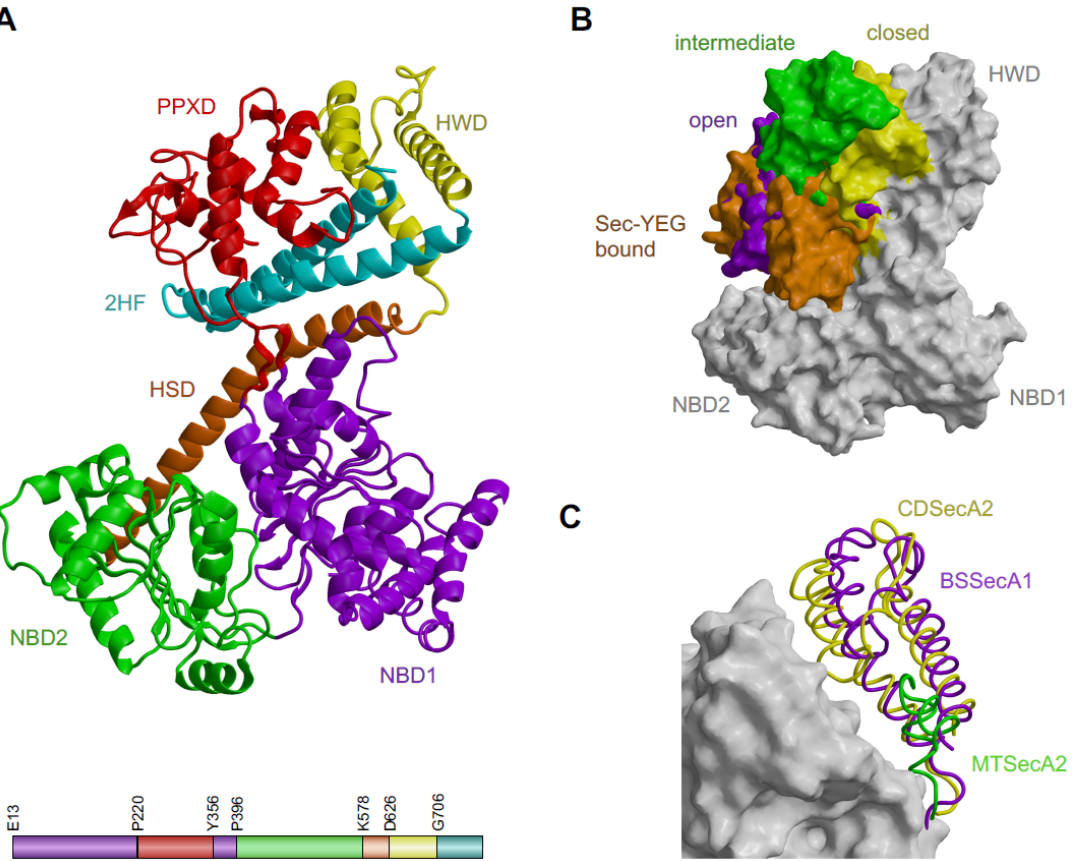
Figure 1. The crystal structure of apo CDSecA2 and conformational variability of SecA homologues. ( A ) The CDSecA2 crystal structure in closed conformation. Domains are color coded: violet, nucleotide-binding domain 1 (NBD1); green, nucleotide-binding domain 2 (NBD2); red, peptide cross linking domain (PPXD); orange, helical scaffold domain (HSD); cyan, two-helix finger (2HF) and yellow, helical wing domain (HWD). Locations of the domains in the linear sequence (bottom) define the color coding. The residues at the beginning of the domains are depicted. ( B , C ) The structures of different SecA molecules were superimposed onto CDSecA2 (PDB ID 6SXH) shown as white surface. ( B ) The colored surface of PPXDs in different conformations. Closed, intermediate and open conformations of CDSecA2 (PDB ID 6SXH), M. tuberculosis SecA2 (PDB ID 4UAQ) [23] and of B. subtilis SecA (PDB ID 3JV2) [19], are shown in yellow, green and violet, respectively. Sec-Y(EG) bound conformation of Thermotoga maritima SecA (PDB ID 3DIN) [24] is shown in orange. ( C ) The HWDs of different sizes presented as ribbons. Yellow, HWD of CDSecA2 (PDB ID 6SXH); violet, HWD of B. subtilis SecA1 (PDB ID 1M6N) [18] and green, HWD of M. tuberculosis SecA2 (PDB ID 4UAQ) [23].